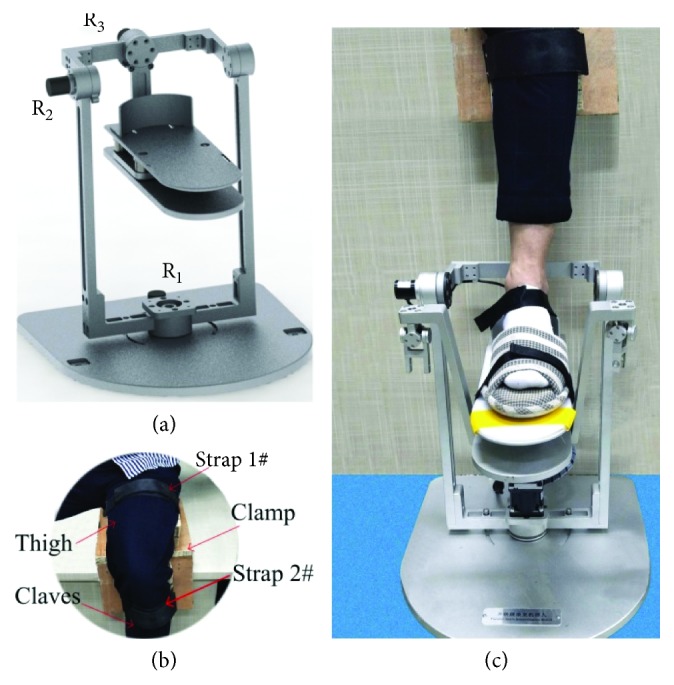
Measurement experiments of PMS. (a) RRR branch of PARR. (b) Wooden clamp. (c) Experimental platform.